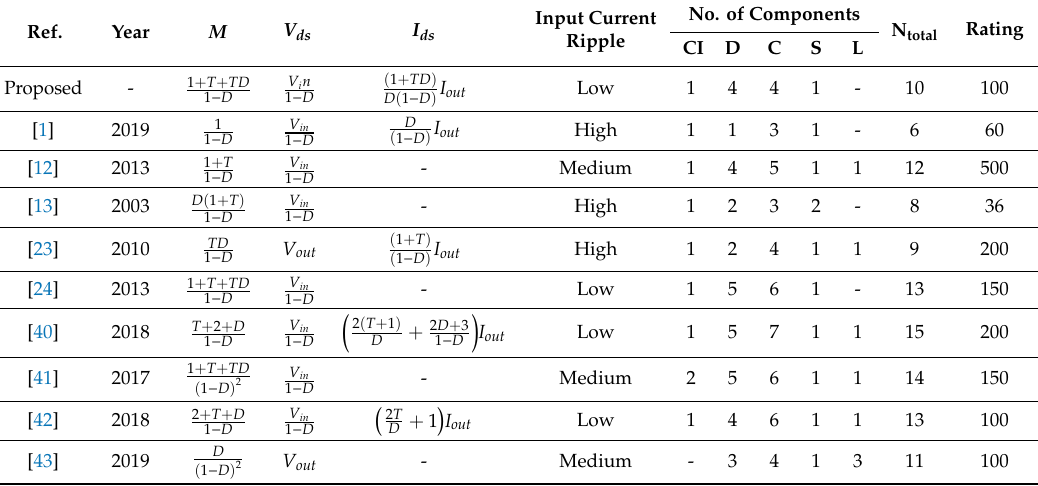
Figure 9. Voltage gain comparison among various converters. Table 2. Performance comparison of the proposed converter with other